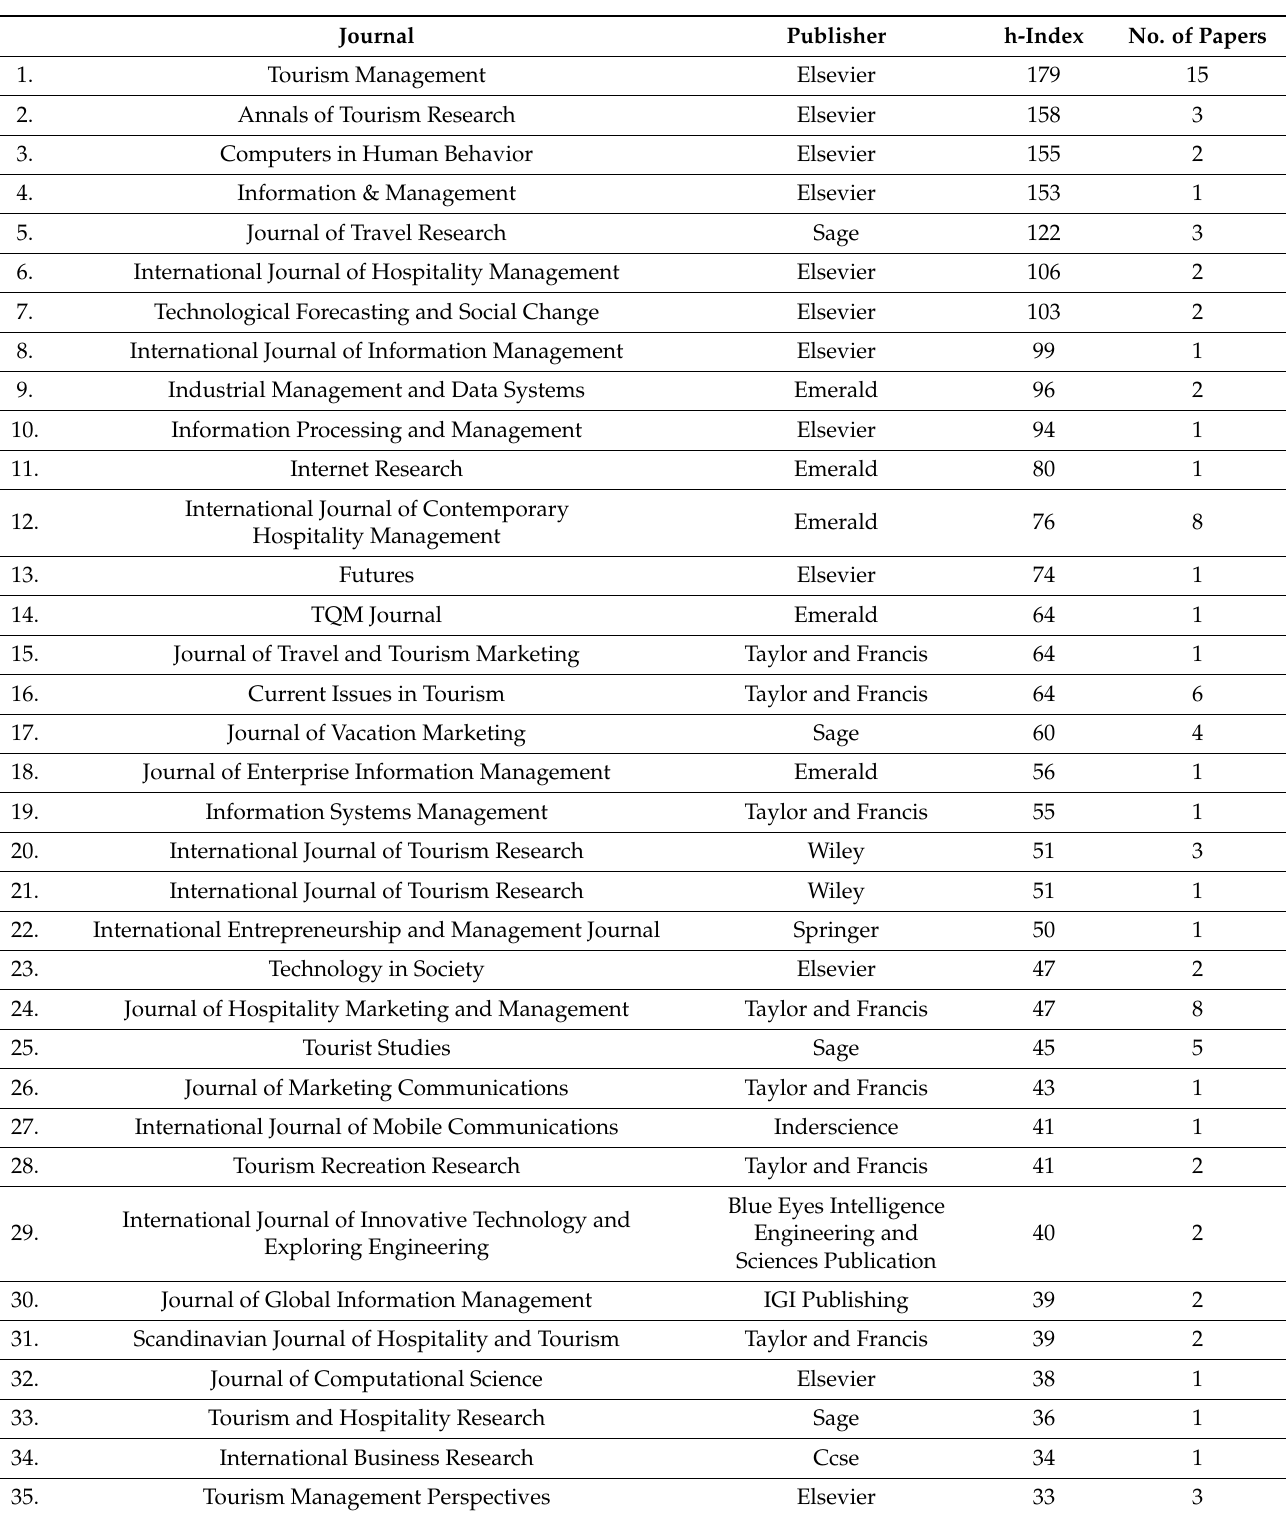
Table 2. Distribution of papers based on